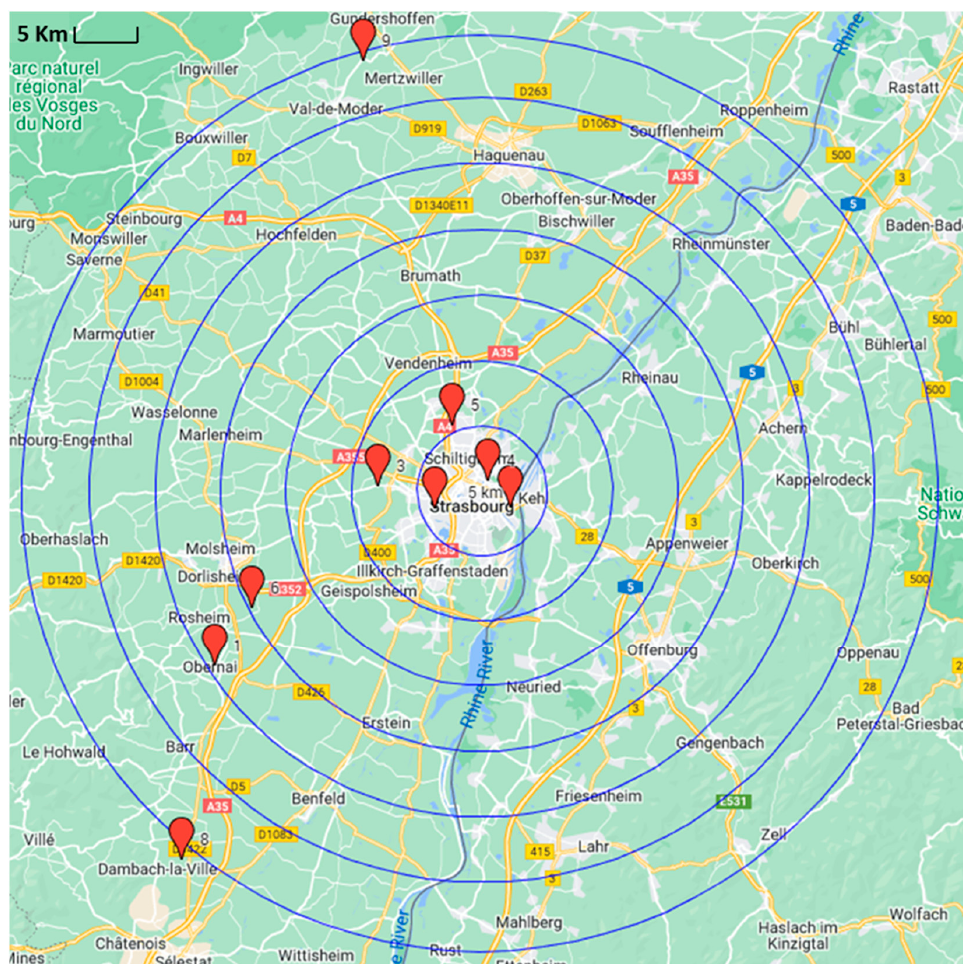
Figure 1. Geographical distribution of the targeted sites (houses are represented by red